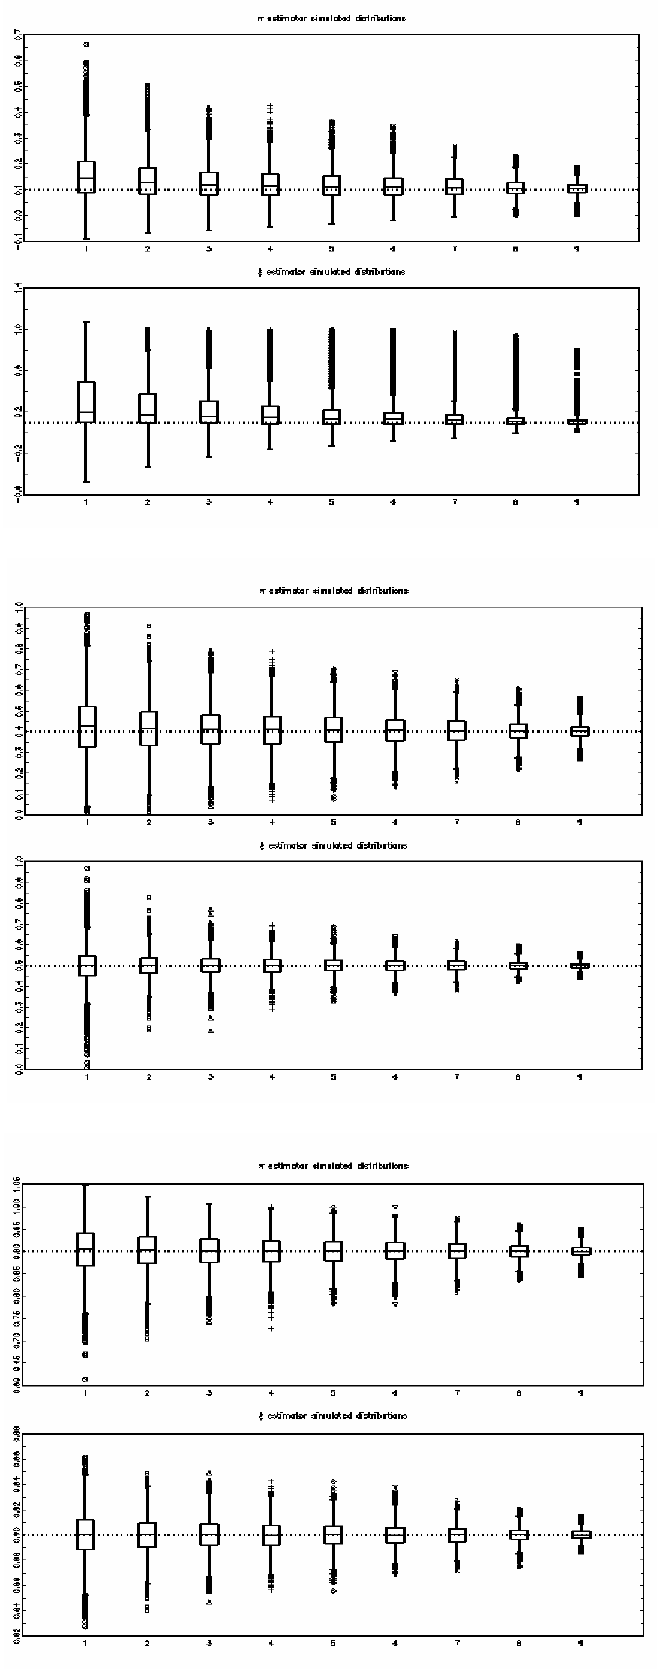
Figure 2 – Box-plots for the ML estimators (models A, E and